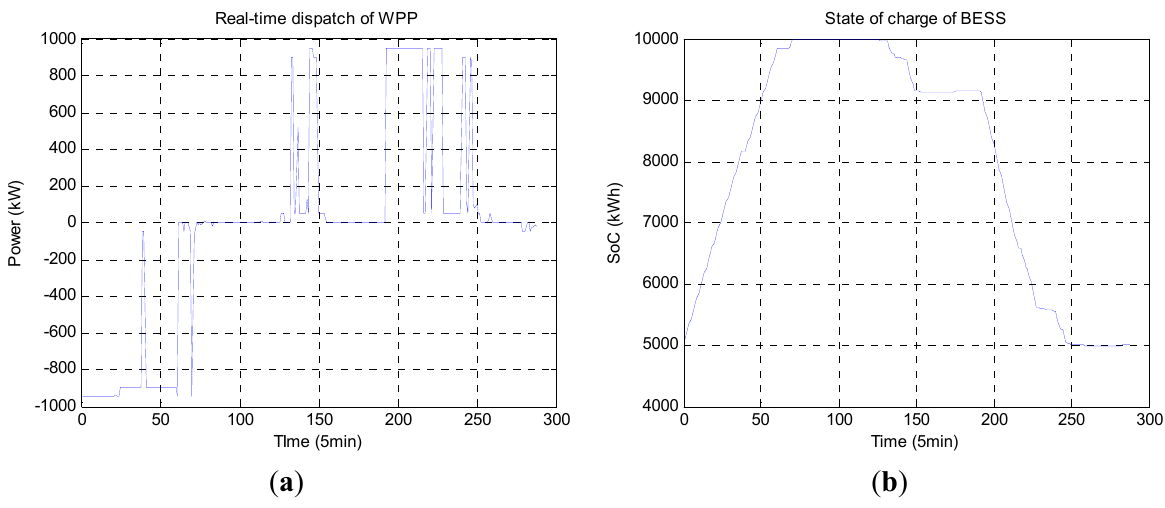
Figure 7. ( a ) The optimal dispatch of WPP; ( b ) The SoC of BES in case 2.